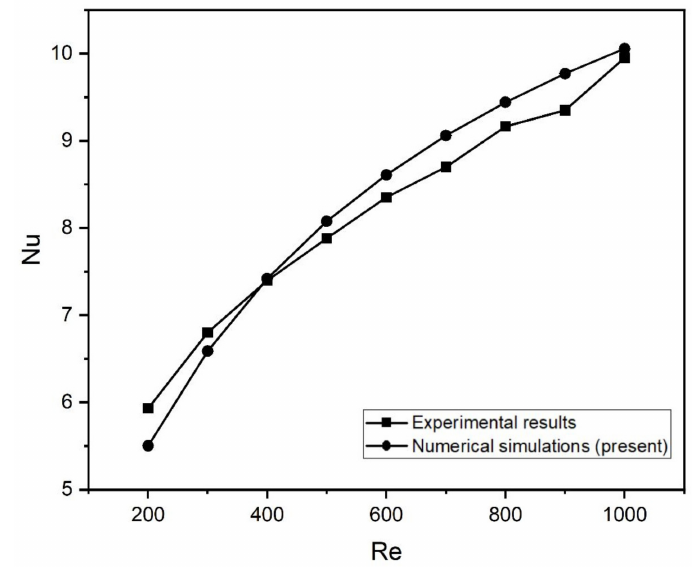
Figure 6. Nusselt number vs. Re for smooth channel MCHS experimental [5] and